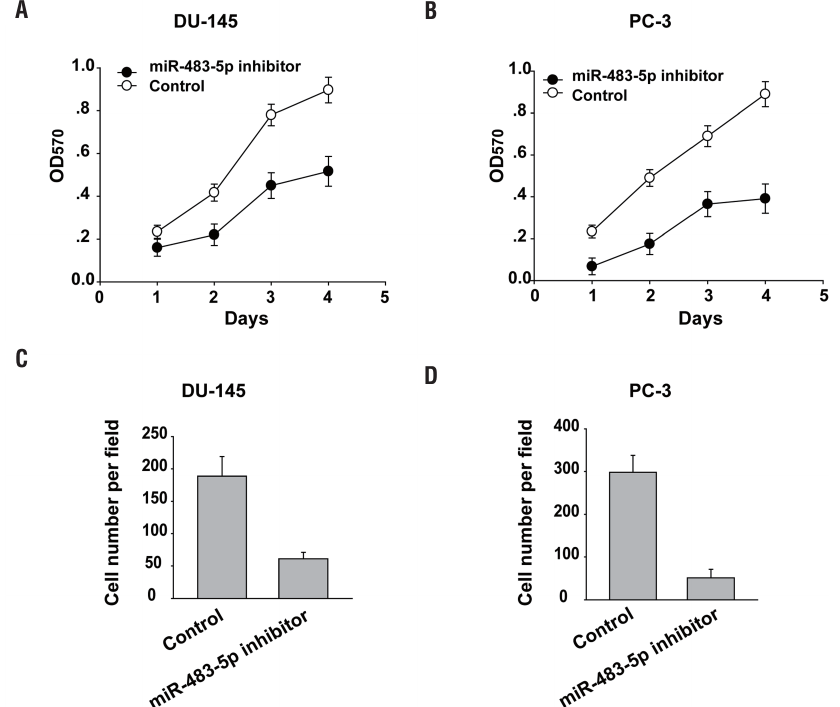
figure 2 - MiR-483-5p inhibition decreases prostate cancer cell growth and invasion. (A) (B) MTT assay was performed after transfection of Du-145 cells (A) or pc-3 cells (B) with the miR-483-5p inhibitor for the indicated time. (c) (D) Invasion assays were used to determine Du-145 cells (c) or pc-3 cells (D) motility. Experiments were performed in